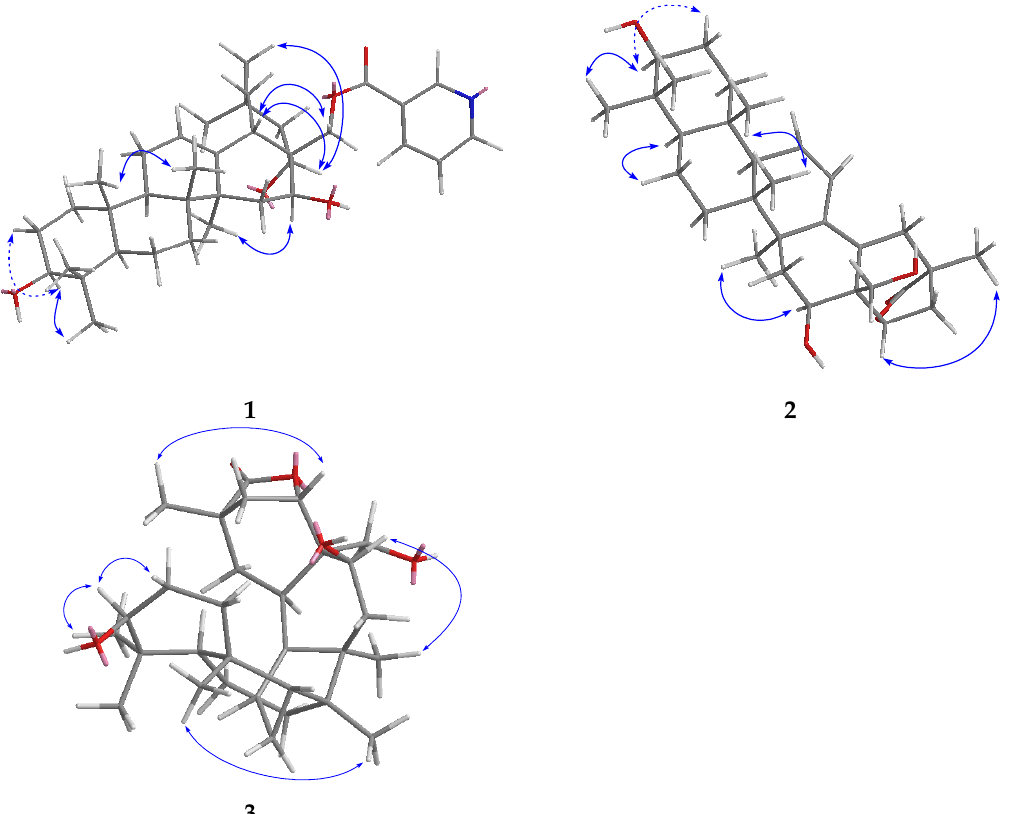
Figure 3. The key NOESY correlations of compounds 1 – 3. Table 1. 1 H NMR and 13 C NMR Data (500 MHz, CD 3 OD) of 1 − 3.